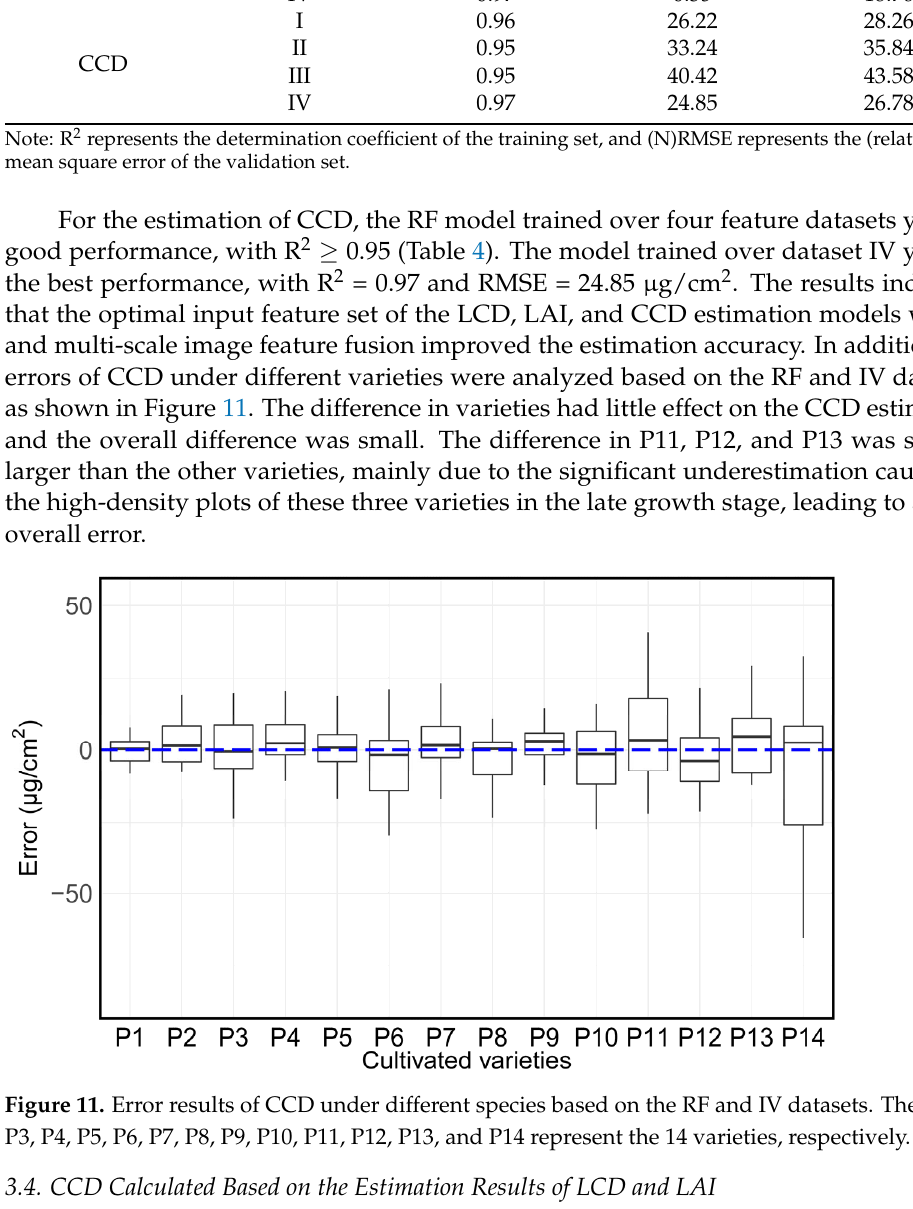
Table 4. Four feature sets were used for RF method estimation of LCD, LAI, and CCD.